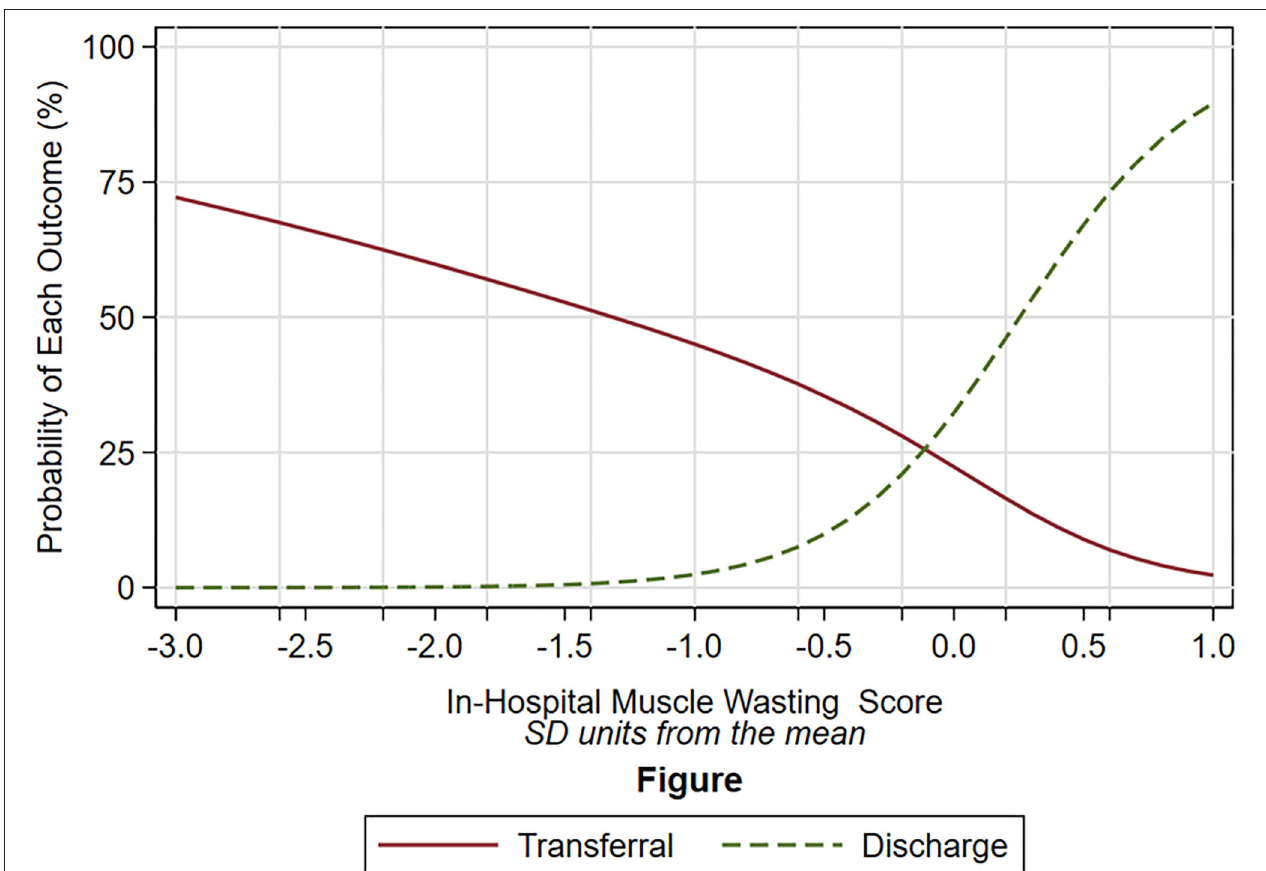
FIGURE 2 | Probability of discharge (dot green line) and of transferal to rehabilitation unit (solid red line) according to the degree of muscle wasting (x-axis). The degree of muscle wasting is expressed as standard deviation unit from the mean, in which a negative number indicates higher muscle wasting, a positive number lower muscle wasting. The different shape of the relation between the dot green line and the solid red line was statistically significant ( P = 0.031). The probability of discharge was based on multinomial logistic model (mortality is not plotted because only five patients died). The independent variable of the multinomial logistic model was the degree of muscle wasting which was estimated by the mixed models (see